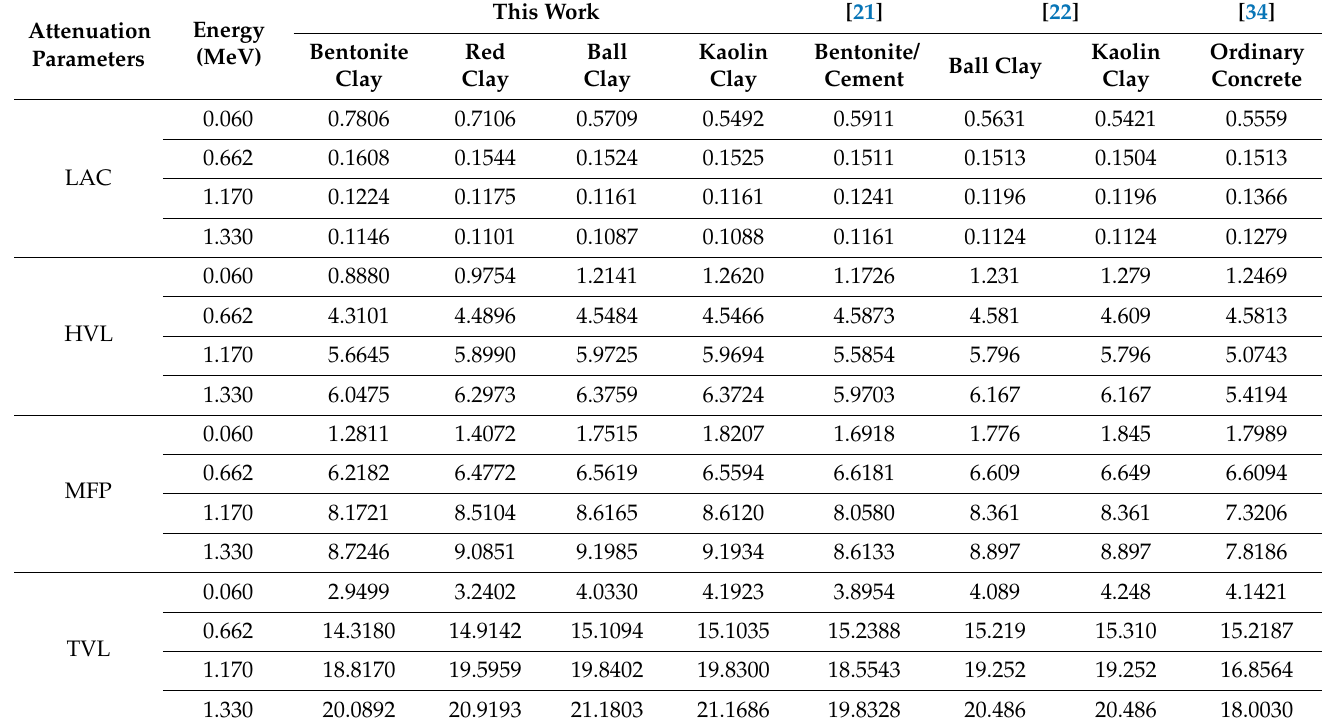
Table 3. The shielding parameters of four clays compared with previously published